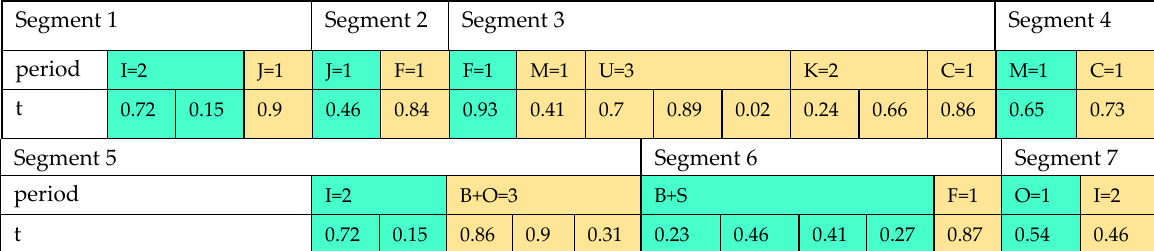
Figure 10. Schematic design of proposed arrays.